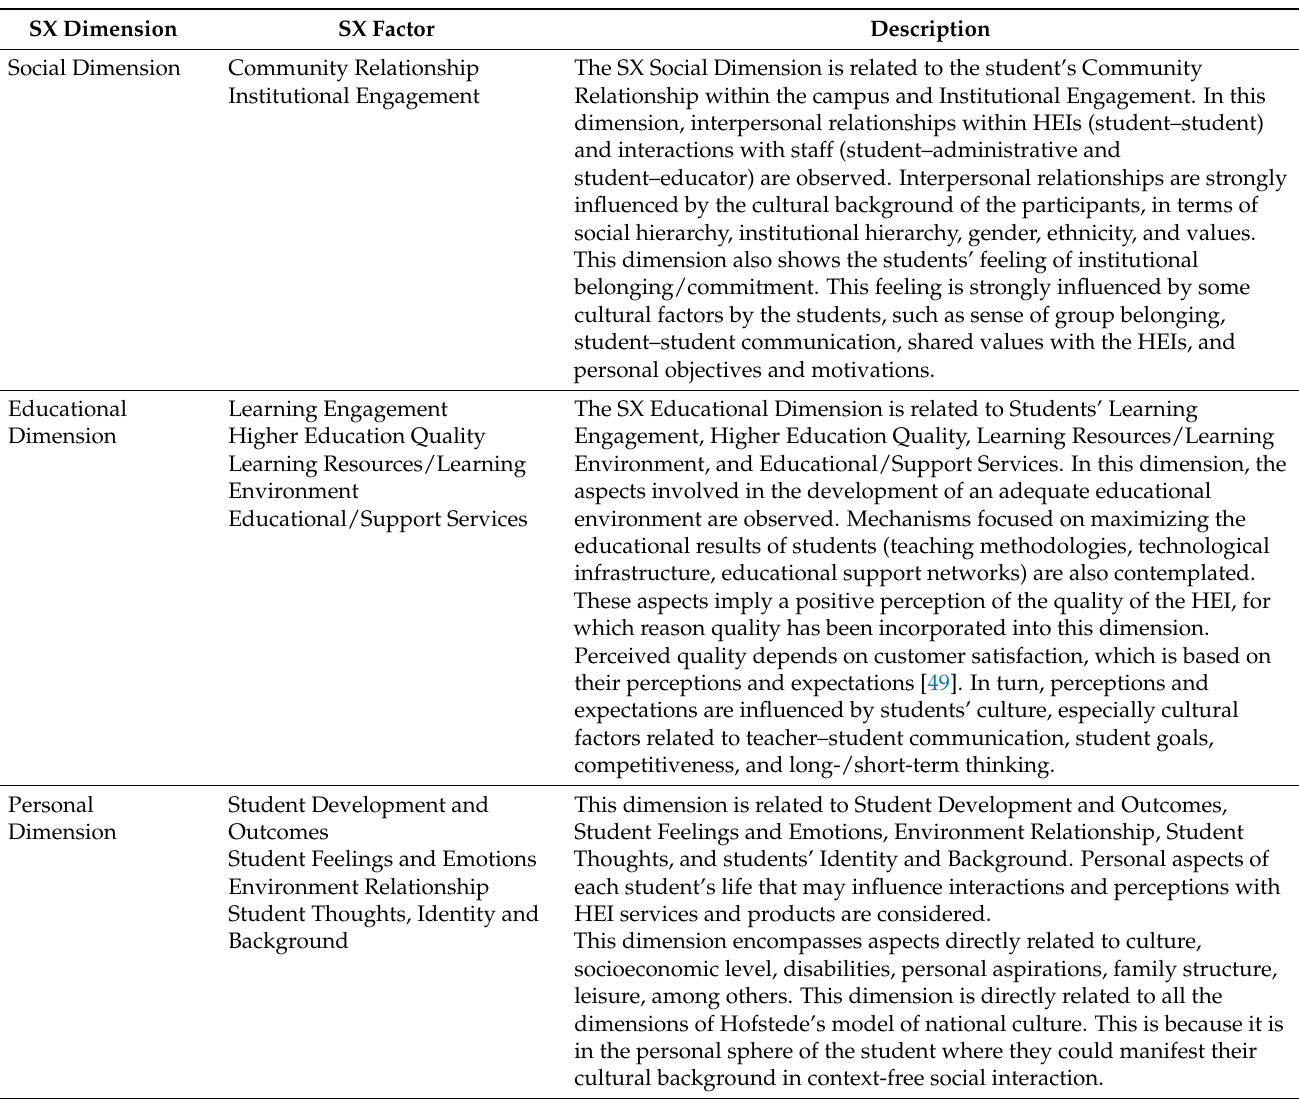
Table 7. SX dimensions including cultural